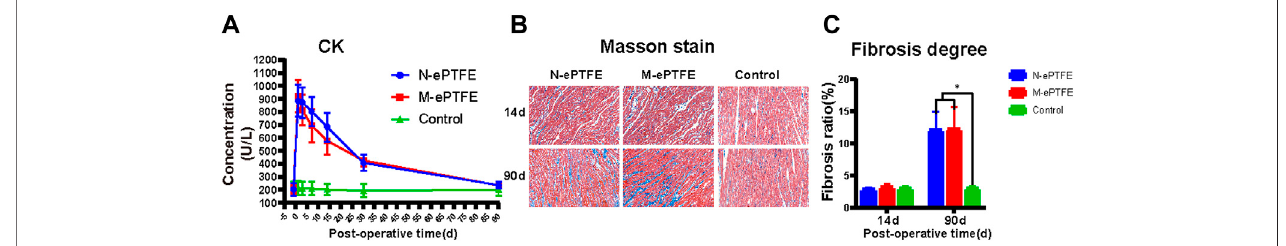
FIGURE 8 | Myocardial injury evaluations (A) Creatine kinase (CK) concentrations in whole blood in the three groups at each time point (B) Masson staining of normal myocardial tissue (Control) or myocardial tissues in contact with the expanded polytetra fl uoroethylene (N-ePTFE) or modi fi ed ePTFE (M-ePTFE) membranes at 14 d and 90 d post-implantation ( fi brotic tissue stained in blue) (C) Quanti fi cation of the degree of fi brosis in the three groups at 14 d and 90 d post-implantation ( n = 6; * p < 0.05).